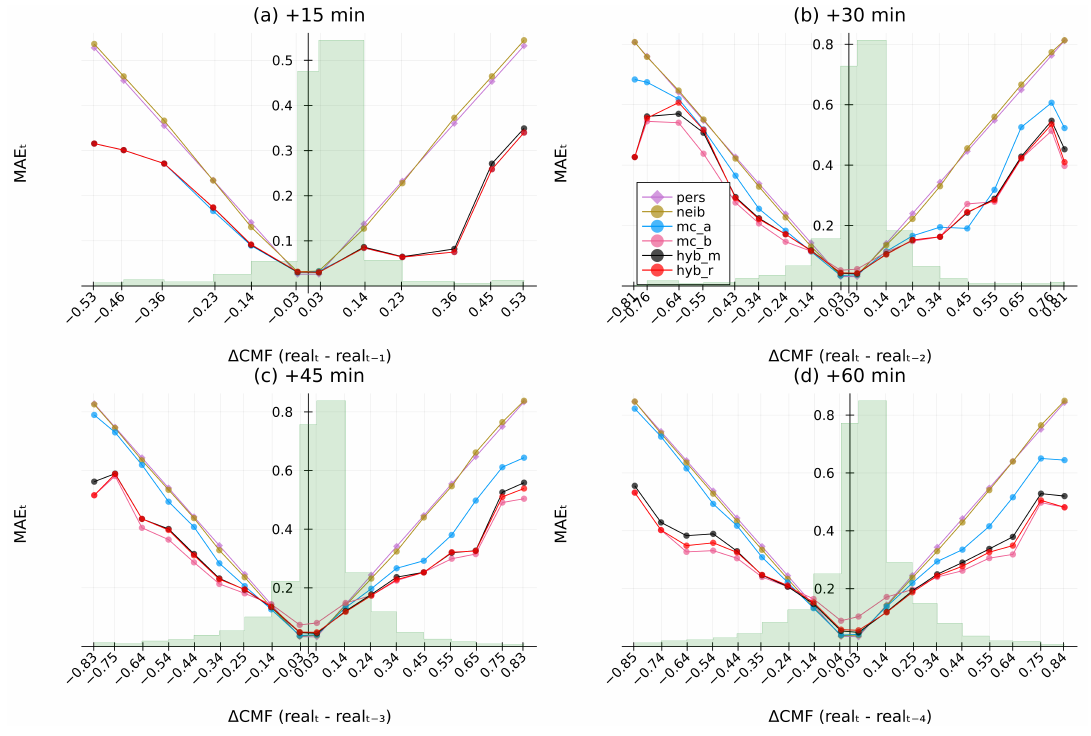
Figure A9. MAE of CMF change for ( a ) 15 min, ( b ) 30 min, ( c ) 45 min, and ( d ) 60 min ahead for